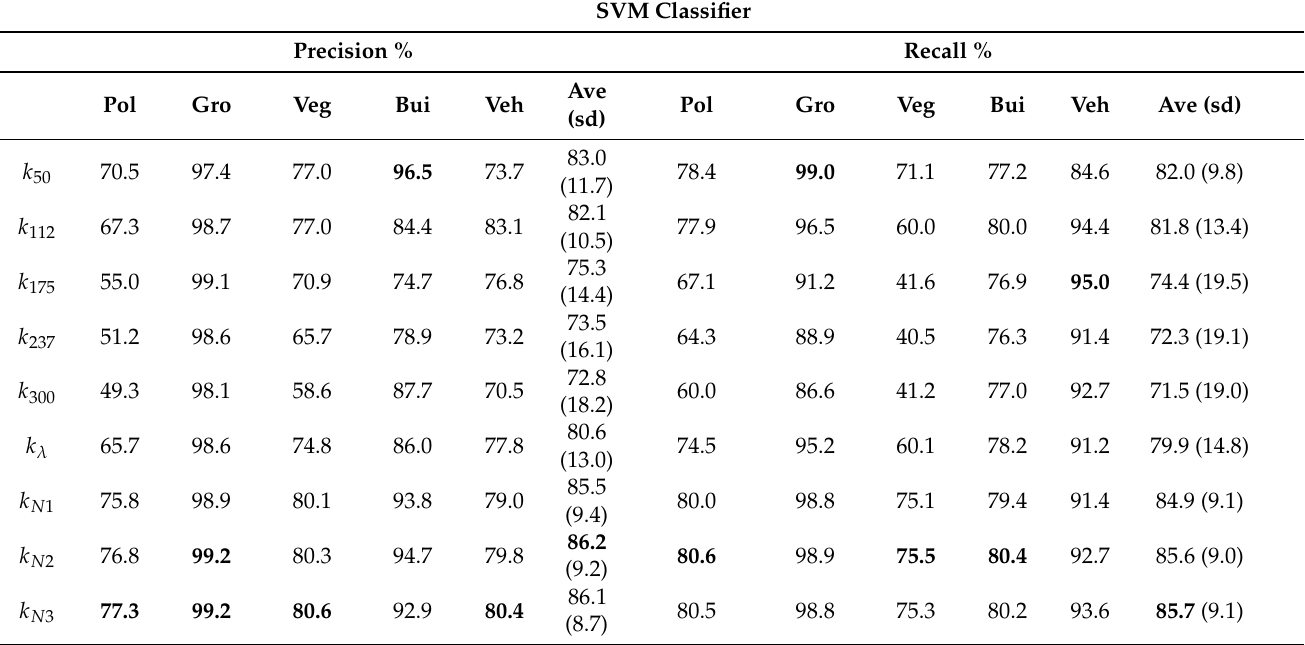
Figure 11 represents boxplots of F1-index for the LR classifier, for each of the classes depending on the scale. The plot at the bottom right is the average value of F1 for the five classes. With a few exceptions, the highest F1 values correspond to the case where two (˜ k (˜ k N 2 ) or three N 3 ) optimum scales for each feature were used. However, the values of the median and the interquantile range are almost the same, so we cannot claim that there are significant differences between both options. For its part, k λ led to the worst performance with low mean values and great dispersion because sometimes the extreme values of the scale were selected.